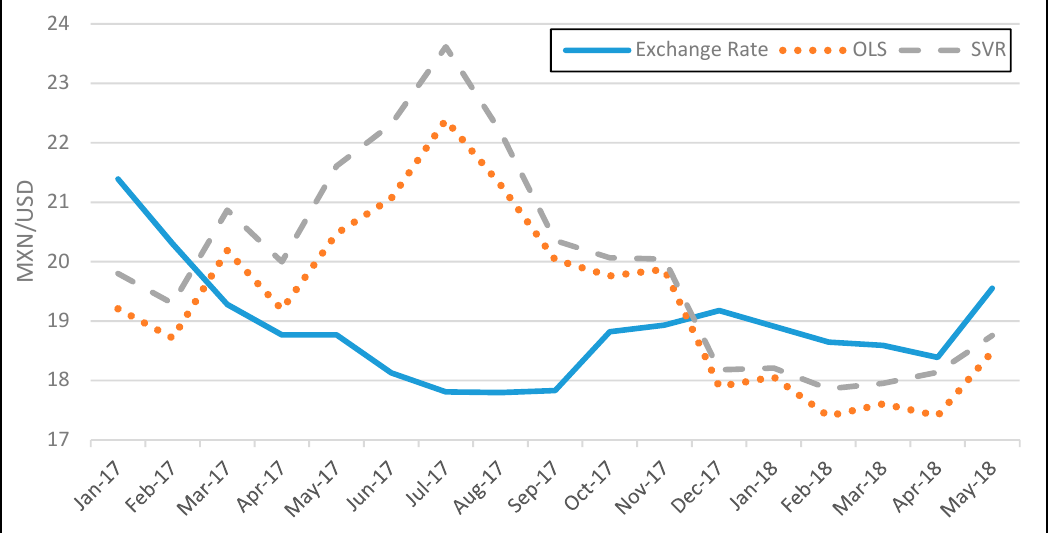
Figure 5. Out-of-sample 12-month ahead exchange rate forecasts for Mexico based on the GPR index for the SVR and OLS model for the period Jan-2017 to May-2018.